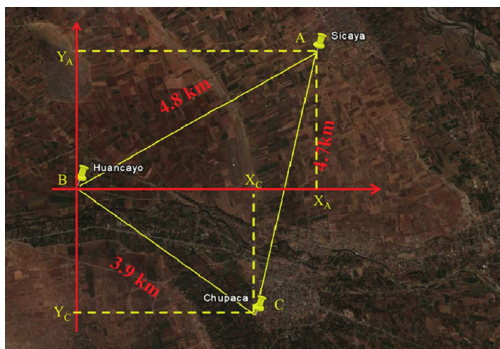
Figure 1: Geographic location of the Huancayo radio interferome- ter test